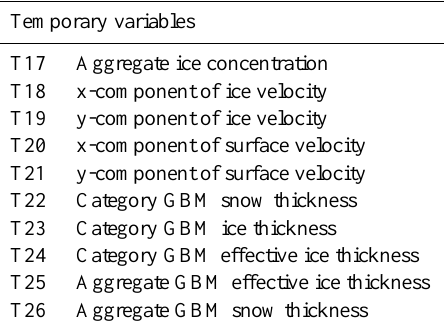
Table 2g. Table of constants as used in model components and coupling code relating to Fig.